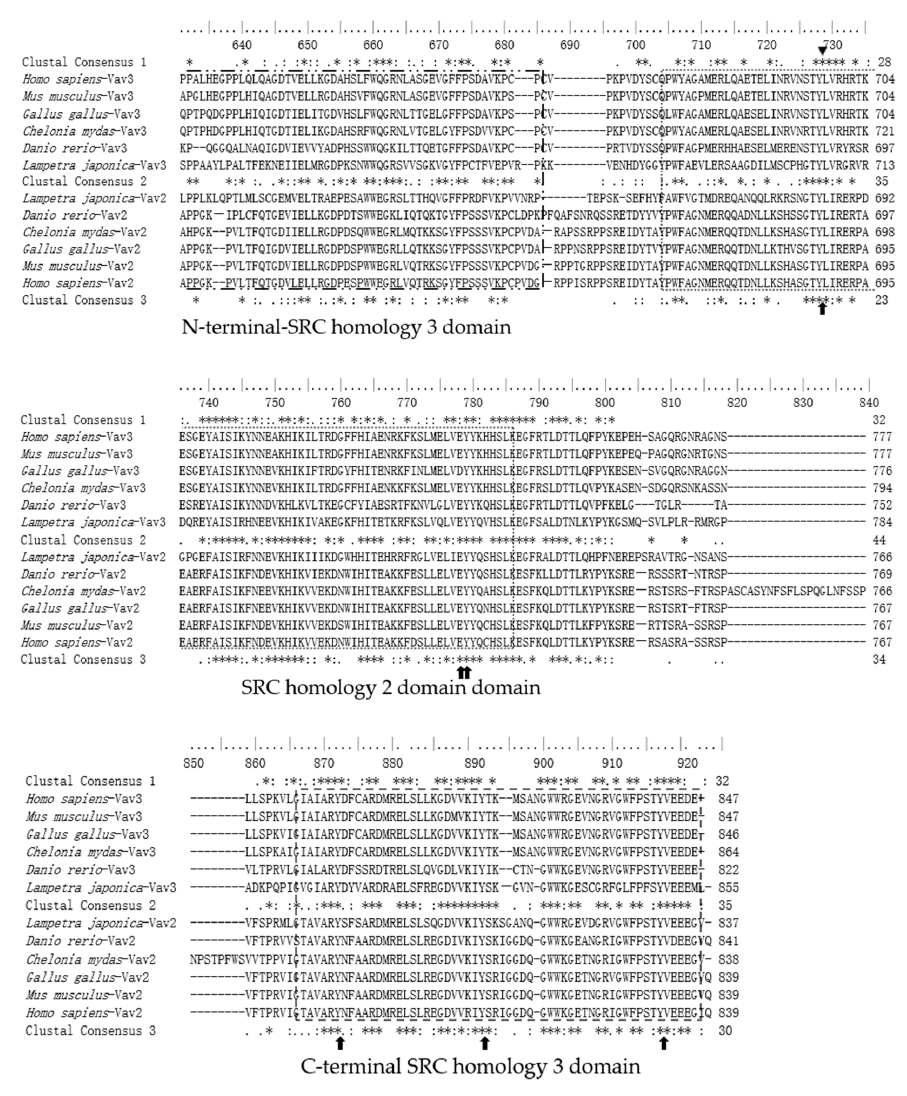
Figure 1. Multiple sequence alignment analyses of lamprey Vav3 protein sequence with several Vav3 and Vav2 molecules of jawed vertebrates. The accession numbers of these protein sequences are listed below. Homo sapiens -Vav3: AAD20349.1; Mus musculus -Vav3: NP_065251.2; Gallus gallus -Vav3: NP_996745.1; Chelonia mydas -Vav3: XP_007055271; Danio rerio -Vav3: NP_001119865.1; Lampetra